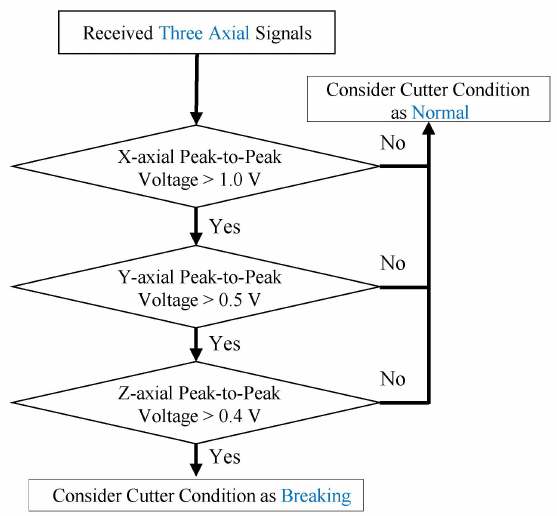
Figure 12. The criterion for monitoring the cutter breaking during